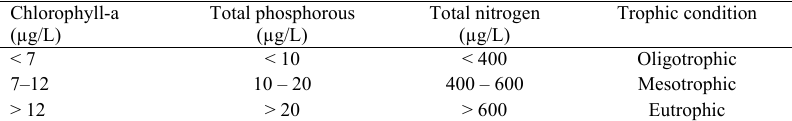
Table 4. Classification of trothic state of lakes based on EPA National Eutrophication Survey (1974) Chlorophyll-a (µg/L)